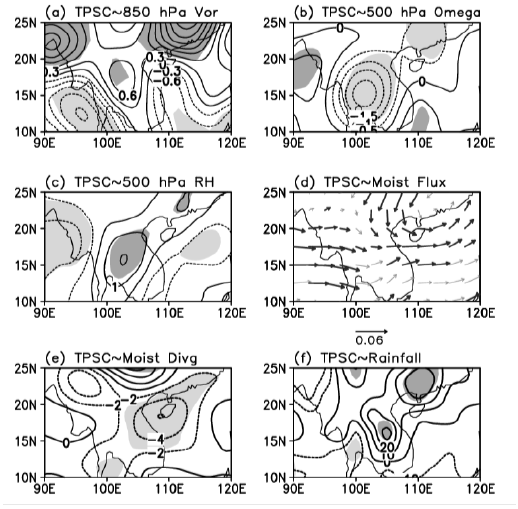
Figure 7. Regression upon snow cover index over the Tibetan Plateau for (a) 850 hPa vorticity (contours 10 -6 s -1 ), (b) 500 hPa vertical pressure velocity (Pa s -1 ), (c) 500 hPa relative humidity (%), (d) moisture flux divergence (10 −7 g m −2 s −1 ), (e) moisture flux divergence (10 −7 g m −2 s −1 ) and (f) atmospheric precipitable water (10 −2 g m −2 ) in the period 1979–2012.Values exceeding the 95% confidence level are bold wind vectors or